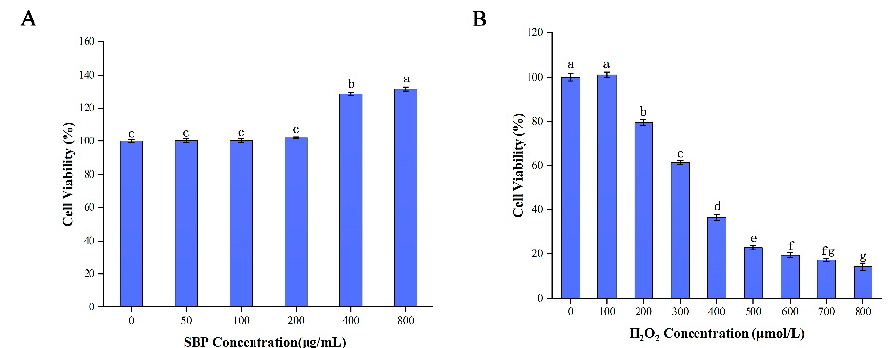
Figure 1. Toxic effects of SBP on HSFs and the establishment of an aging model. ( A ) The toxic effects of different concentrations of SBP on HSFs were detected by the CCK-8 method; ( B ) the effect of different concentrations of H 2 O 2 on the cell viability of HSFs was detected by the CCK-8 method. Results are the mean ± SD of three independent experiments. Bars with different letters are significantly different ( p < 0.05).